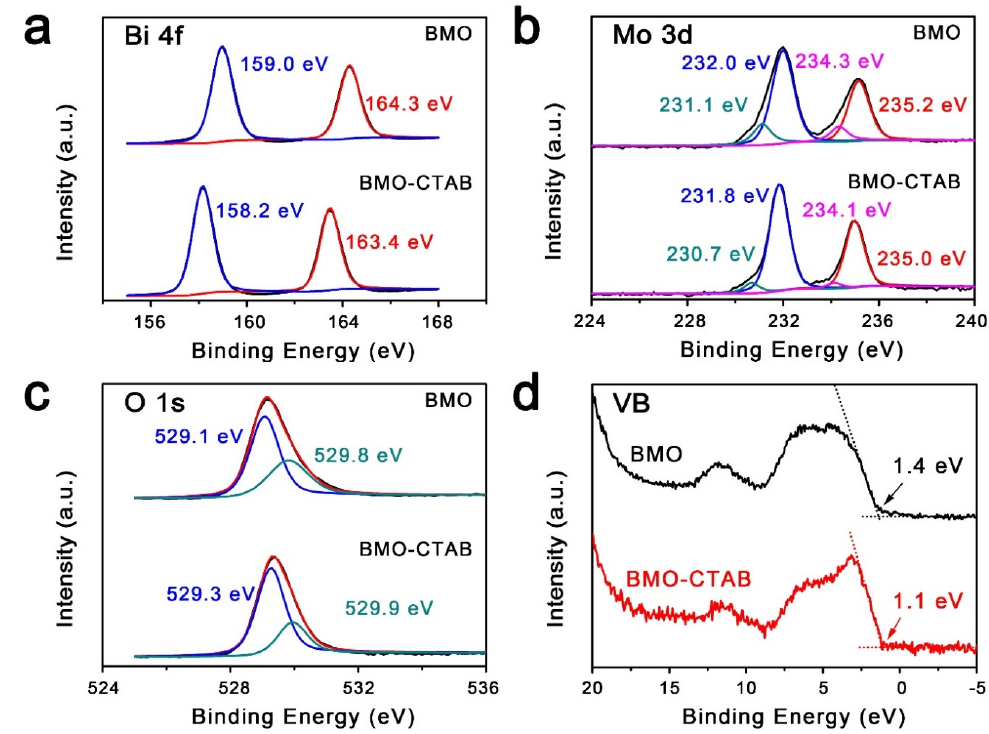
Figure 4. The Bi 4f ( a ), Mo 3d ( b ), O 1s ( c ) and VB ( d ) XPS spectra of the BMO and BMO-CTAB.